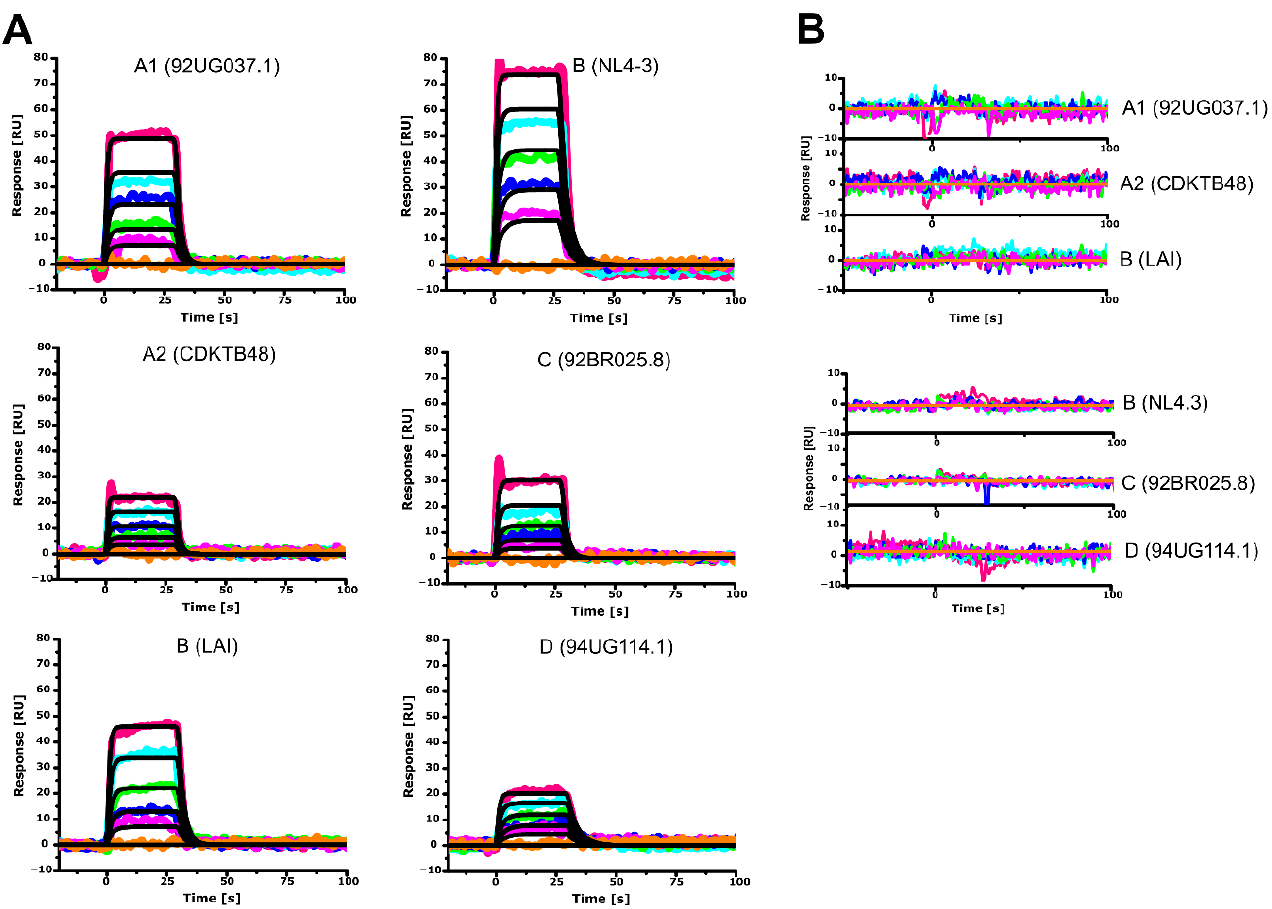
Figure 2. Sensorgrams depicting the interaction of hCaM-1 with immobilized clades of the HIV-1 MA protein. Human CaM-1 concentrations of 0, 6.25, 12.5, 25, 50, and 100 µ M were tested and represented as orange, magenta, green, blue, cyan, and red lines. Colored lines indicate experimental data, whereas black lines indicate fitting to a simple 1:1 binding model. ( A ) In the presence of 5 mM CaCl 2 or ( B ) in the presence of 10 mM EDTA. Colored lines represent actual data, whereas black lines indicate fitting to a 1:1 interaction model. Experiments were performed in triplicate.